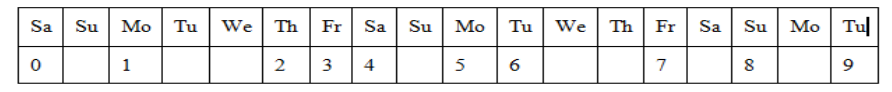
Table 1. Basic timeline for a